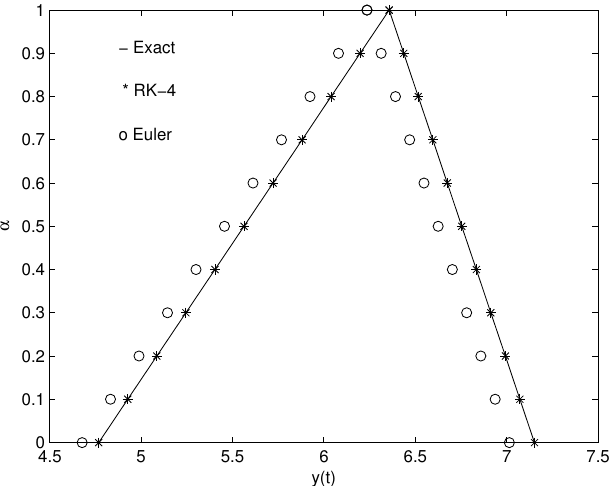
Figure 5. Graphical comparison between the approximate and exact solutions for h = 0.1, α ∈ [ 0,1 ] and t = 3.